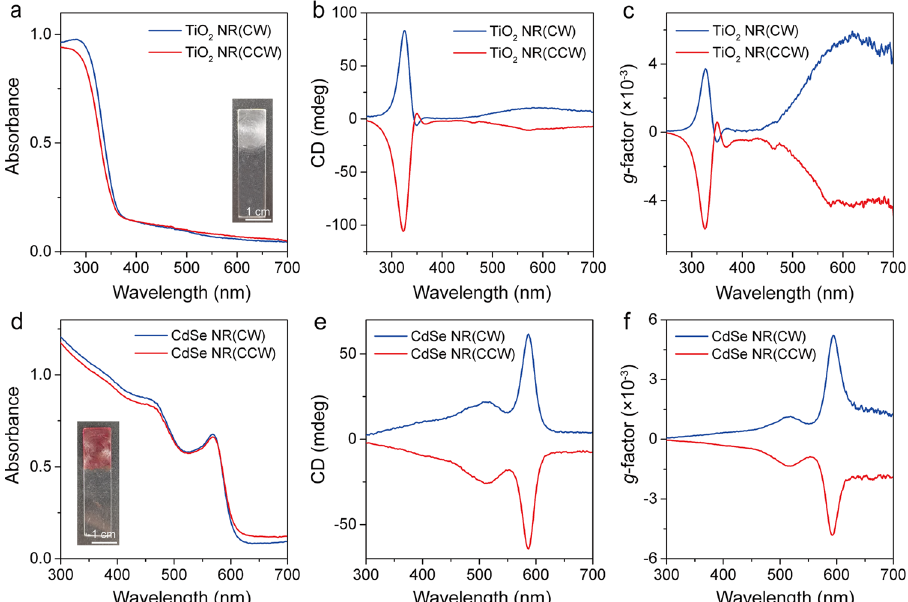
Fig. 4 | Chiroptical properties of other NR assemblies subjected to mechanical grinding.a – c UV − Visabsorptionspectra,CDspectraand g -factorcurveofTiO 2 NR